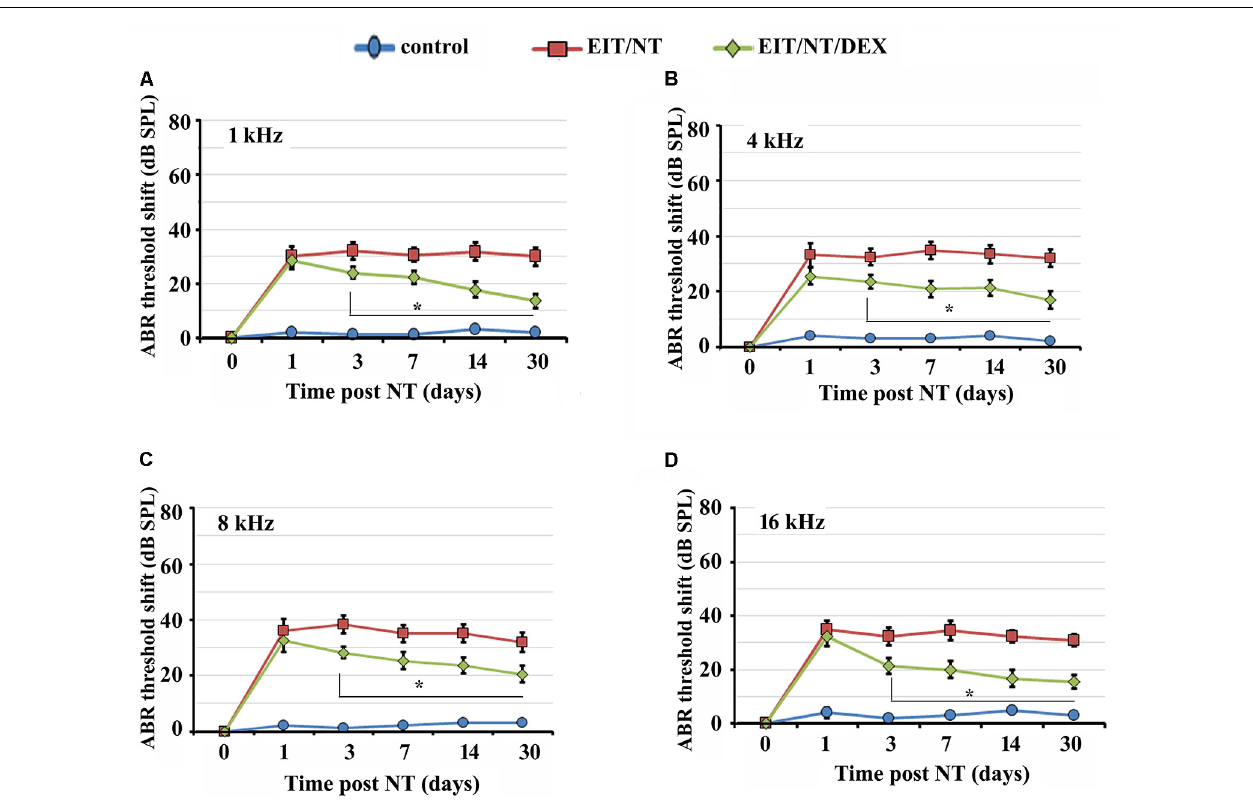
FIGURE 3 | Dexamethasone eluting electrodes provides otoprotection. Guinea pigs were implanted with dexamethasone eluting or non-eluting electrode and subjected to NT. ABR thresholds were significantly lower in animals implanted with dexamethasone eluting electrodes compared to guinea pigs receiving